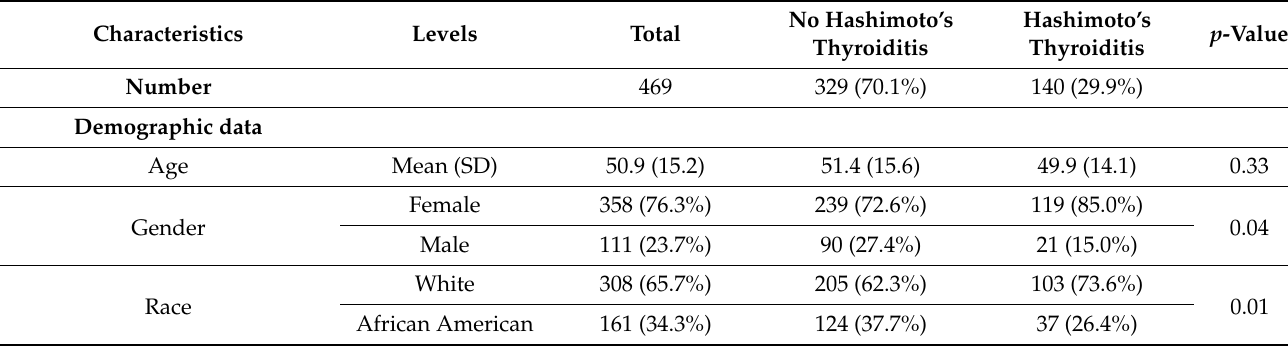
Table 1. Baseline characteristics of differentiated thyroid cancer patients who underwent thyroid surgery with subgroup analysis based on underlying Hashimoto’s thyroiditis. Data are presented as number and percentage, mean and standard deviation, or median and interquartile range. Percentage is reported per the designated group. Two-sided Chi-Square, Student’s t , and Mann–Whitney U tests were used. The study cohort had a mean follow-up of 46.08 ± 58.76 months. ATA: American Thyroid Association, RAI: Radioactive iodine, PTMC: Papillary thyroid micro-carcinoma, PTC: Papillary thyroid carcinoma, FTC: Follicular thyroid carcinoma, TT: Total thyroidectomy, CLND: Central lymph node dissection, LLND: Lateral lymph node dissection, SD: Standard deviation, IQR: Interquartile